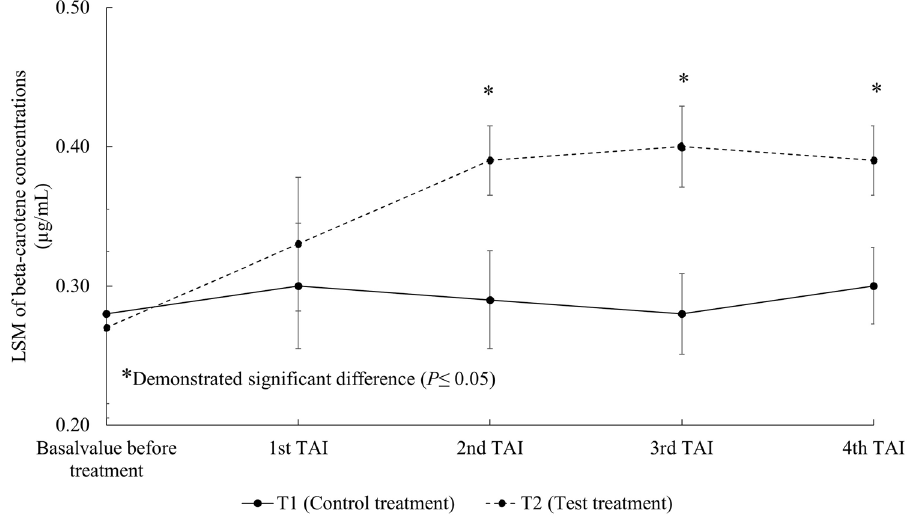
Figure 4. Least-squares means (LSM) of beta-carotene concentrations (µg/mL) in milk at the same time of each timed artificial insemination (TAI). T1 = Control treatment, T2 = Test